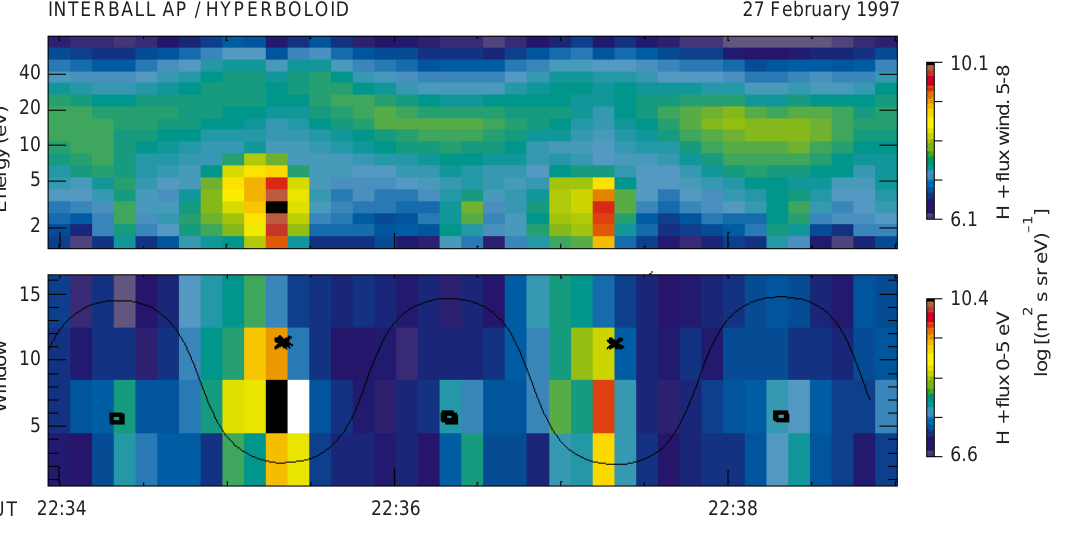
Fig. 10. Energy-time spectrogram for windows 5 to 8 of the A16 analyzer (top panel) and window-time spectrogram for energies below 5 eV (bottom panel) obtained for H + ions on 27 February 1997 between 22:34 and